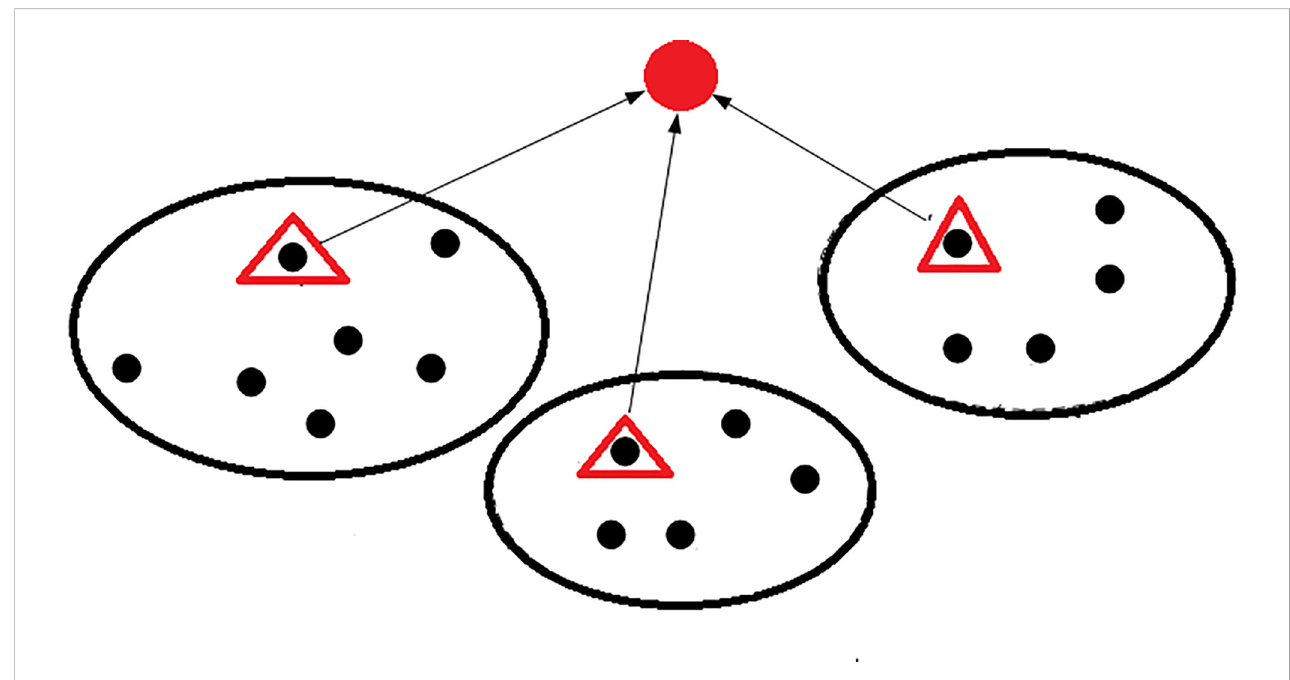
FIGURE 4 Clustering Basic